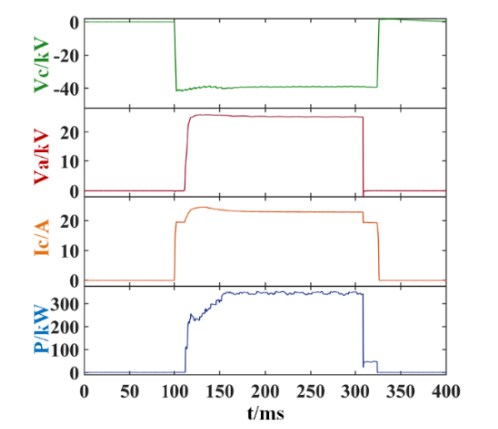
Fig. 8. Waveforms of a typical shot.